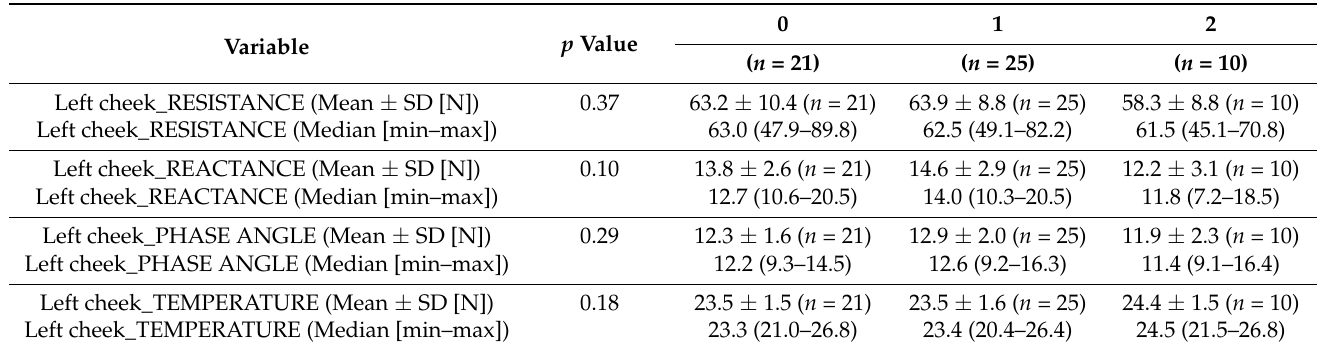
Table 2. Comparison between measurements in different types of lesion in OLP patients (left cheek), classified as: no lesions = 0; striations = 1; erythema or erosion = 2. Electrical values are in Ohm. 1 = Wilcoxon’s rank-sum test.